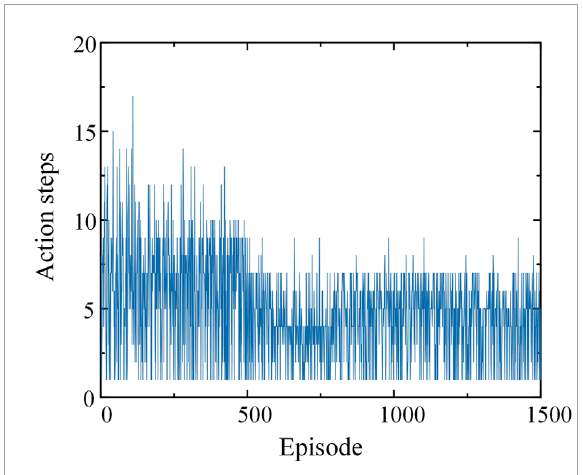
FIGURE 6 Change of reward value during training.